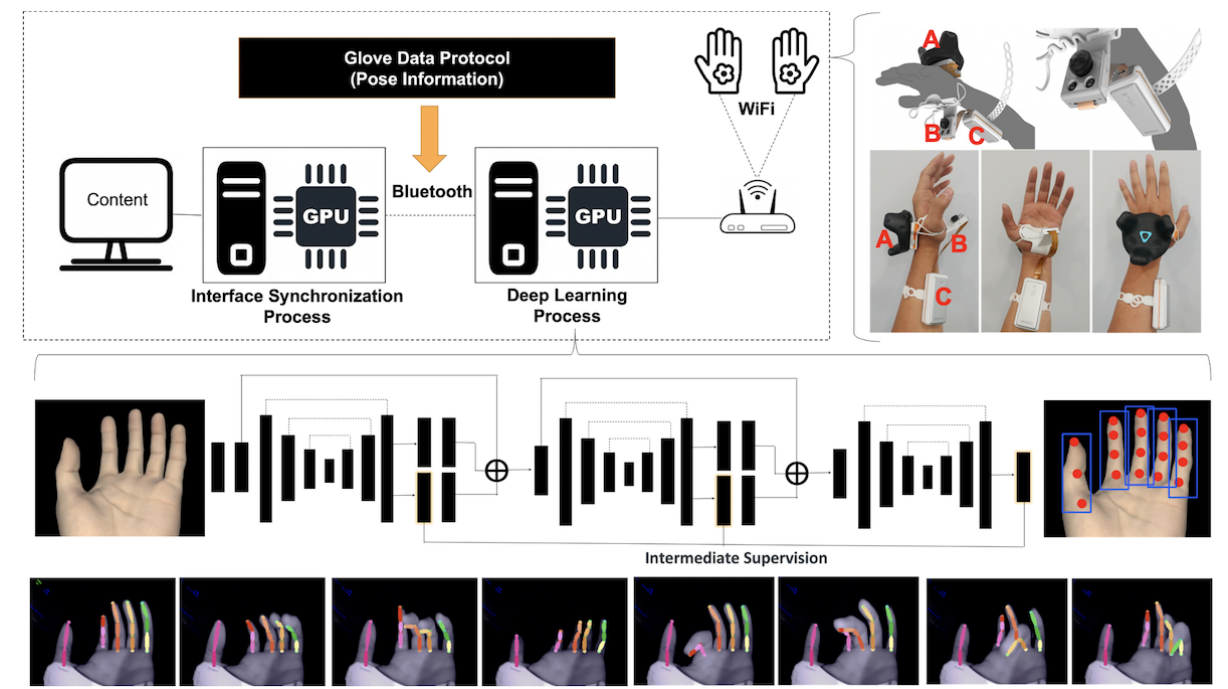
Figure 1. The overall system architecture of the module for hand pose estimation: (A) motion tracking module, (B) camera module, (C) transmission/reception module and